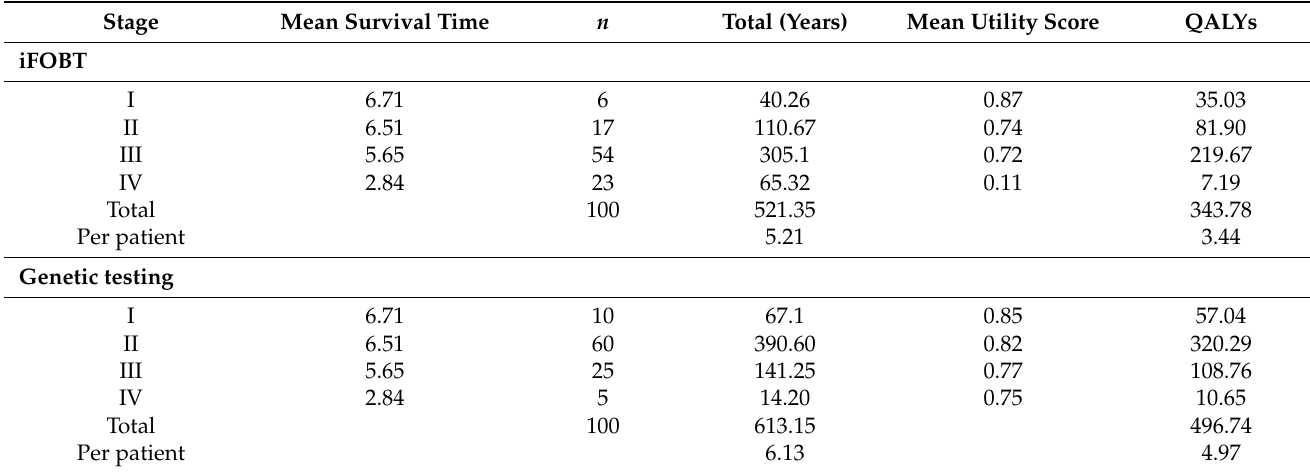
Table 4. Mean survival times for patients who underwent the iFOBT and genetic